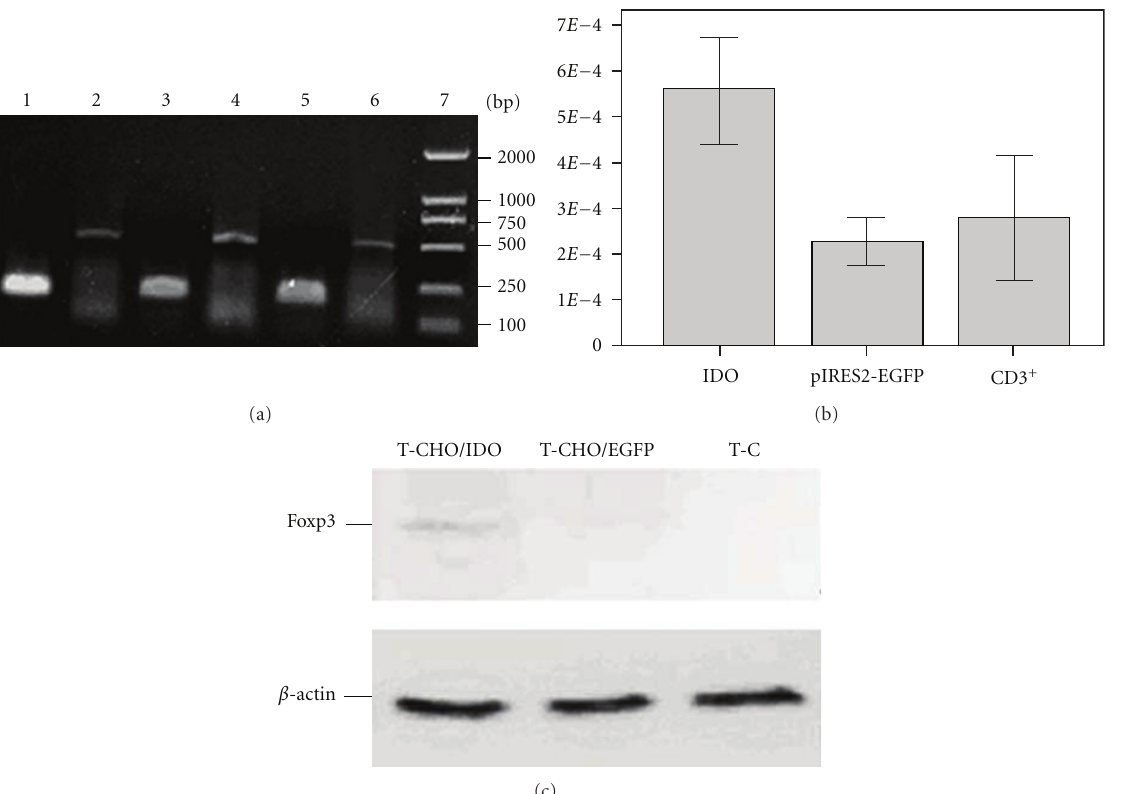
Figure 4: Foxp3 expression in CD3 + T cells was upregulated both at mRNA and protein levels after coculture with IDO/CHO cells. The expression of Foxp3 gene at mRNA and protein levels in treated and untreated T cells were detected using qRT-PCR assay and Western Blot method. (a) After 7 day coculture, the relative mRNA level of Foxp3 in the CD3 + T cells treated with the CHO/IDO cells was significantly higher than that in the CD3 + T cells treated with the CHO/EGFP control cells or untreated CD3 + T cells (lane 1: β -actin in the CD3 + T control cells; lane 2: Foxp3 in the CD3 + T control cells; lane 3: β -actin in the T cells treated with CHO/IDO cells; lane 4: Foxp3 in the T cells treated with CHO/IDO cells; lane 5: β -actin in the T cells treated with CHO/EGFP cells; lane 6: Foxp3 in the T cells treated with CHO/EGFP cells; lane 7: DL2000 Marker. (b) The mRNA amount of Foxp3 in the CD3 + T cells stimulated by the CHO/IDO cells was significantly higher than that in the CD3 + T cells stimulated by the CHO/EGFP cells and the unstimulated CD3 + T cells control. (c) Foxp3 expression at protein level in treated and untreated T cells detected by Western Blot analysis. Foxp3 expression was exclusively detected in the cell lysates of CD3 + T cells treated with CHO/IDO cells, indicating a 48kD protein band reactive to a Foxp3-specific monoclonal antibody (lane 1: Foxp3 in CD3 + T cells treated with CHO/IDO cells; lane 2: Foxp3 in CD3 + T cells treated with CHO/EGFP cells; lane 3: Foxp3 in control CD3 + T